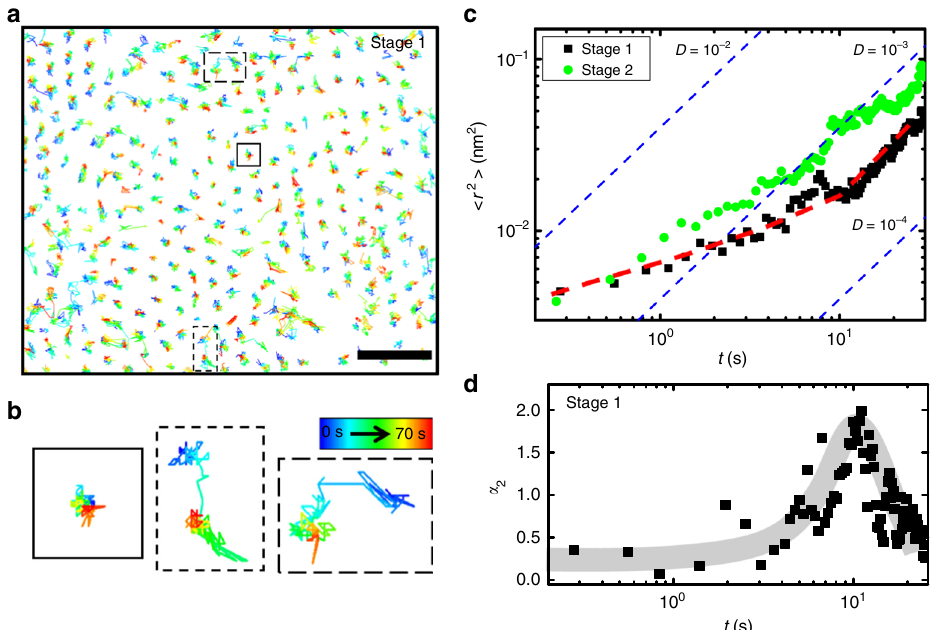
Fig. 5 C 70 dynamics in fullerene molecular liquid. a C 70 molecular trajectories at the relatively ordered molecular packing structure. Scale bar, 2 nm. b Zoomed-in molecular trajectories from panel a , showing sporadic jumps. c Displacement behaviors of molecules at two different stages of observation. The red dashed line is a guide to the eye for stage 1 data. d Calculated non-Gaussian parameter α 2 at stage 1. The gray area is a guide to the